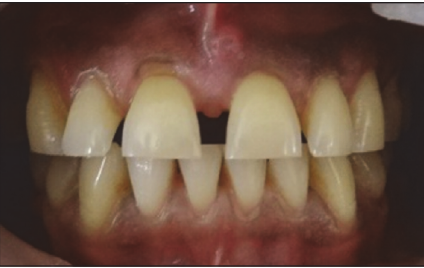
Figure 1: Preoperative intraoral view of the patient shows interden- tal spacing in maxillary anterior regions.